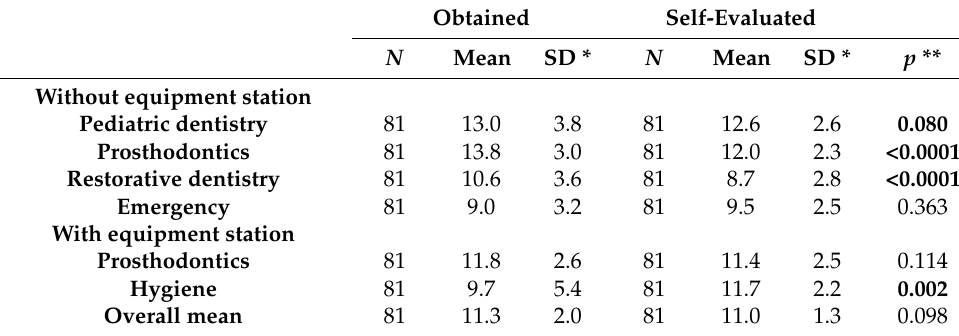
Obtained Self-Evaluated N